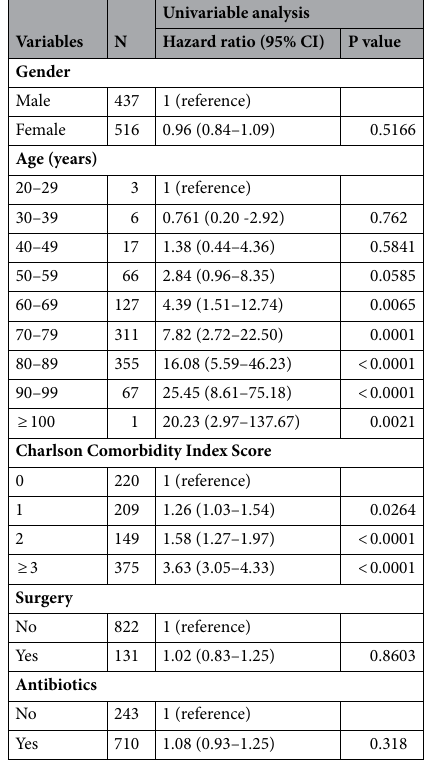
Table 4. Cox proportional hazard models of thirty-day mortality by